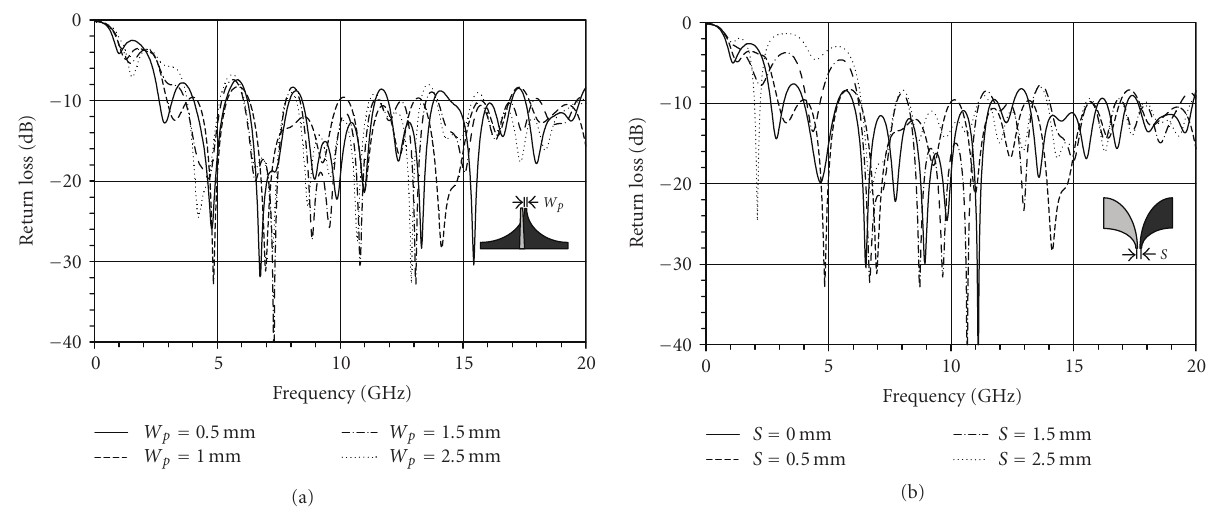
Figure 6: Return loss for varying parallel strip